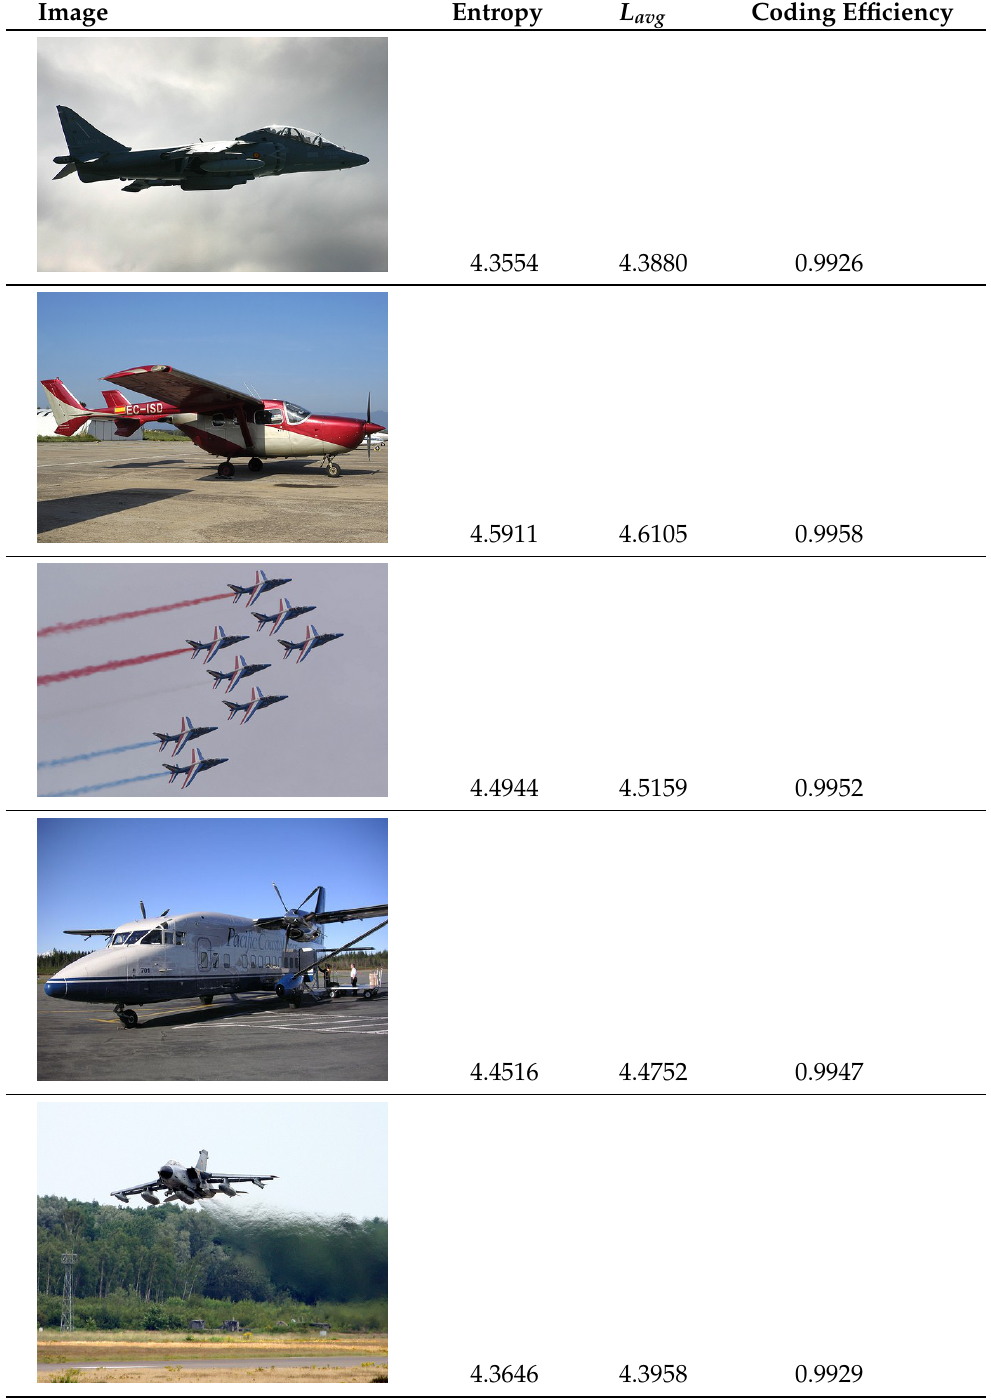
Table 11. The Huffman coding